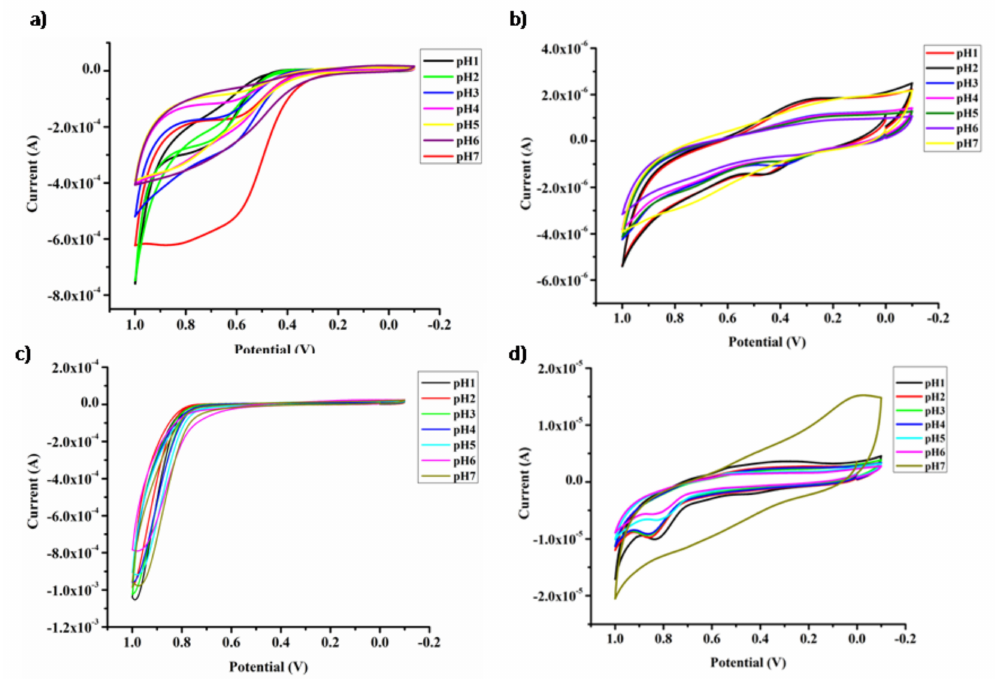
Figure 4. Cyclic voltammogram of bare Pt electrode as a working electrode for ( a ) Cys (10 − 2 M) and ( c ) Met (10 − 2 M) at di ff erent pH; ( b , d ) are Cyclic voltammogram of 3% CNOs–PS / Pt electrode as a working electrode for Cys and Met, respectively, at a scan rate of 0.1 V /